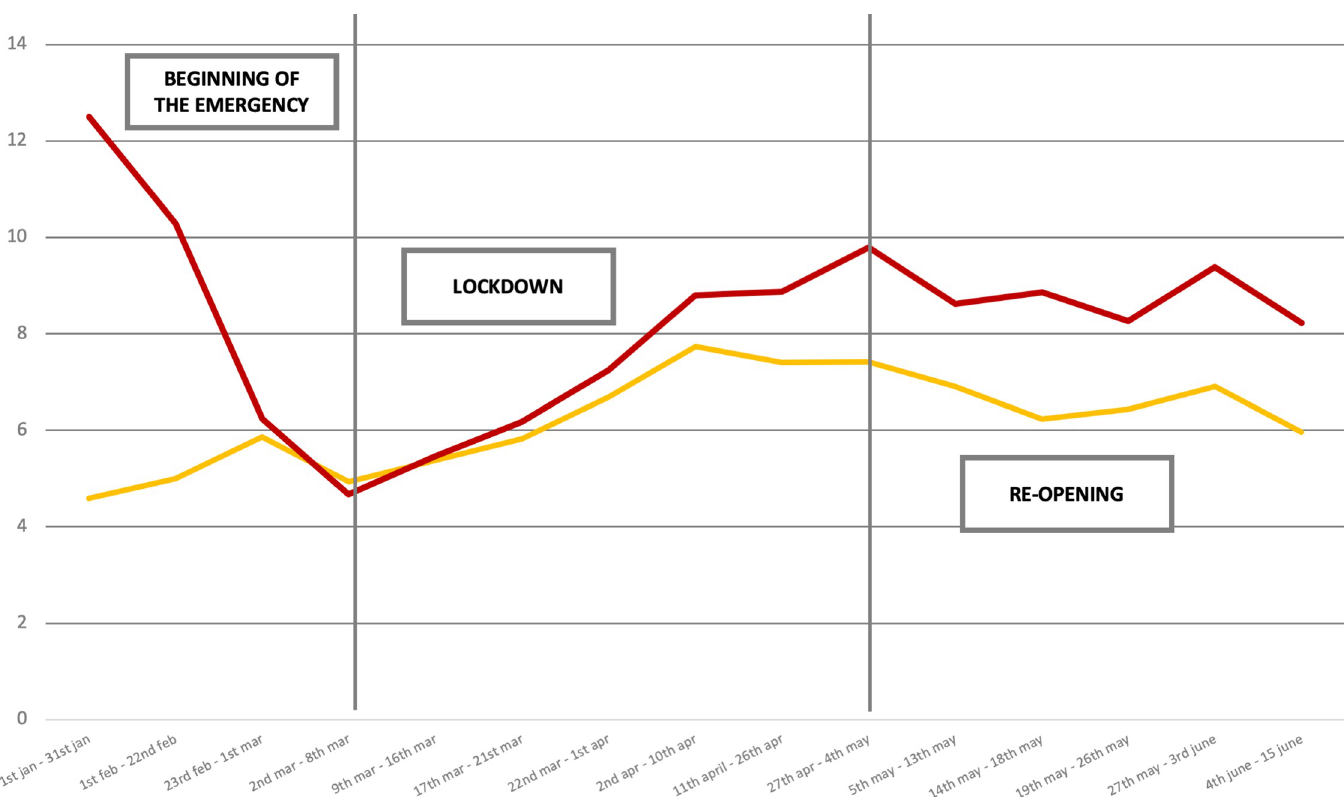
Fig 3. Scientific salience of the “SARS-CoV-2 general corpus” (in red; μ = 8.23) and of all the articles the eight Italian daily newspapers published (in yellow; μ = 6.22).